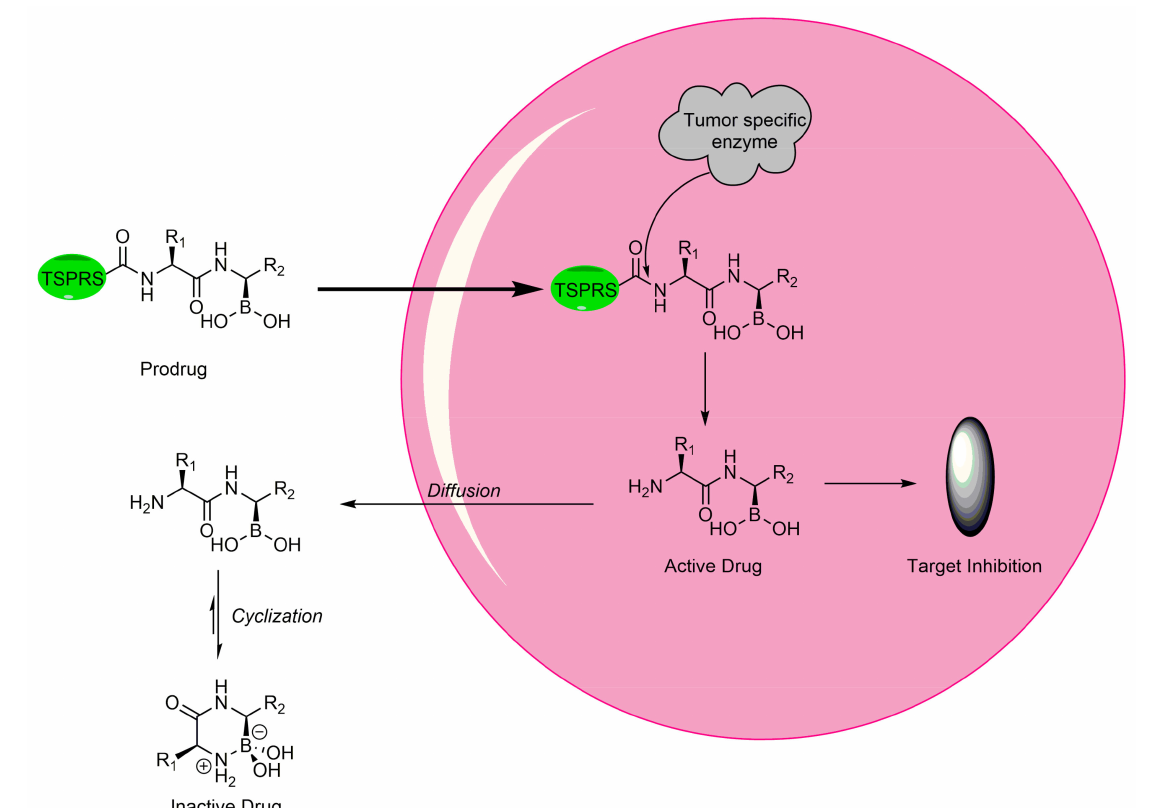
Figure 4. Pro-softdrug boronic acid inhibitor-targeting tumor cells. Tumor-specific protease recogni- tion sequences (TSPRS) are recognized by tumor-specific proteases that cleave TSPRS, releasing the active drug inside the tumor cell. The drug will go on to inhibit the target, before slowly diffusing outside of the tumor cell. The physiological pH outside the tumor cell causes the drug to undergo cyclization, deactivating it